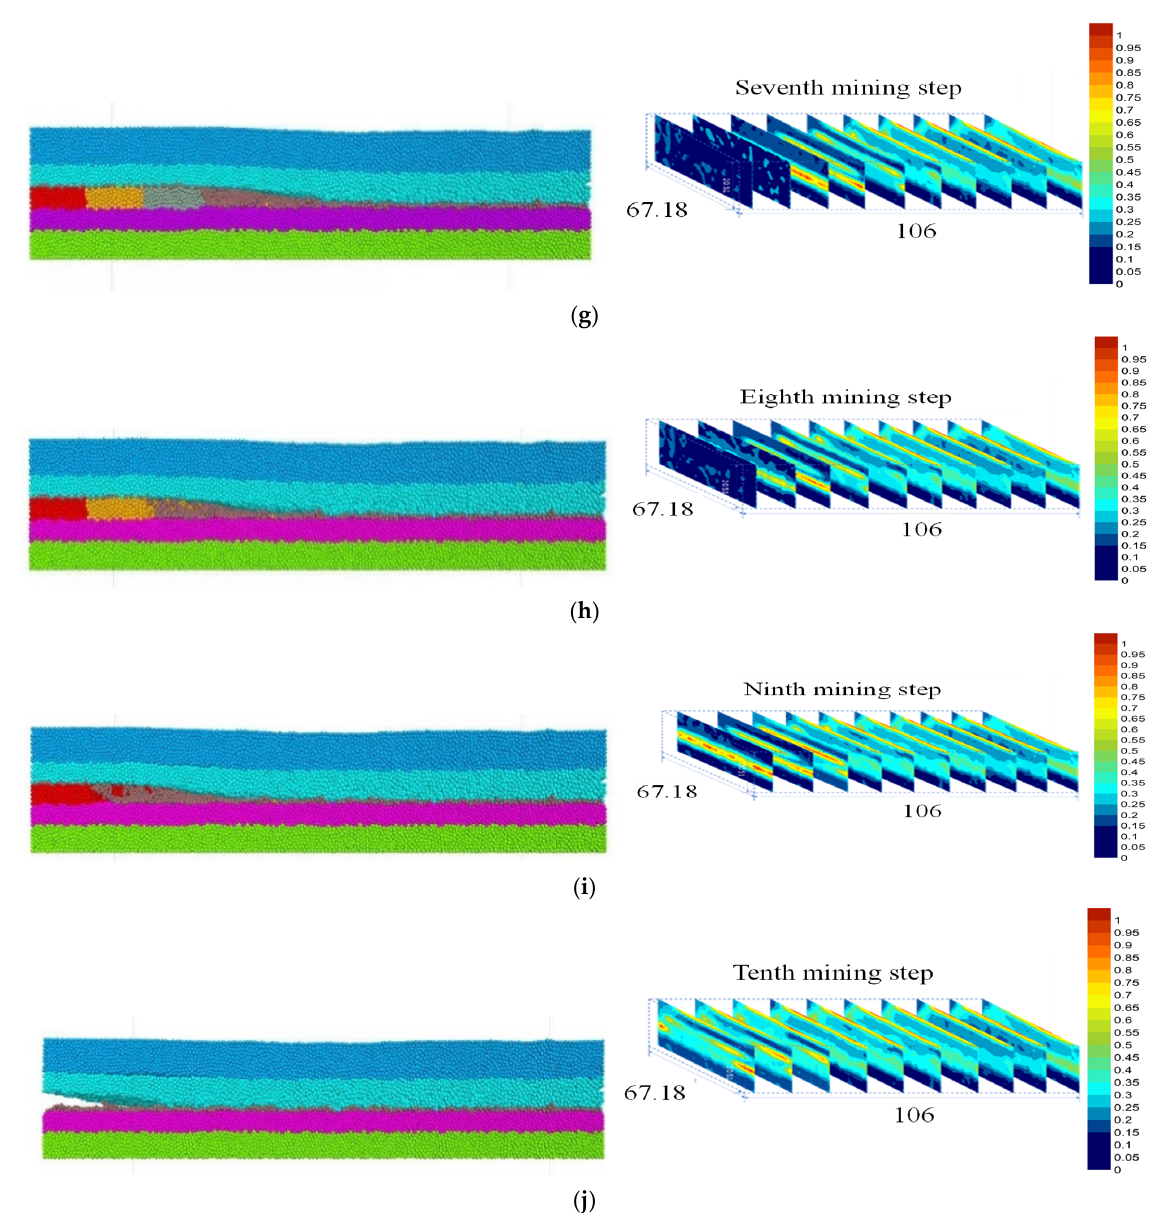
Figure 6. Overlying stratum collapse and porosity change pattern during coal seam caving (own elaboration). ( a ) First caving step. ( b ) Second caving step. ( c ) Third caving step. ( d ) Fourth caving step. ( e ) Fifth caving step. ( f ) Sixth caving step. ( g ) Seventh caving step. ( h ) Eighth caving step. ( i ) Ninth caving step. ( j ) Tenth caving step.